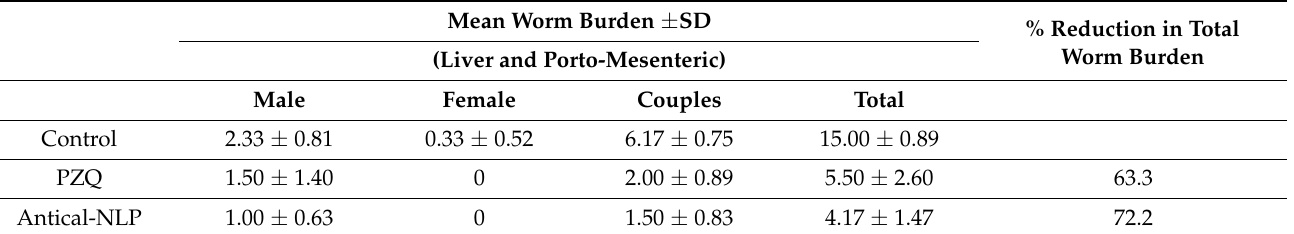
Table 3. Effect of PZQ and anti-calpain-NLP (single dose 250 mg/kg four weeks post infection) on worm load and sex in S. mansoni -infected mice sacrificed six weeks post infection.